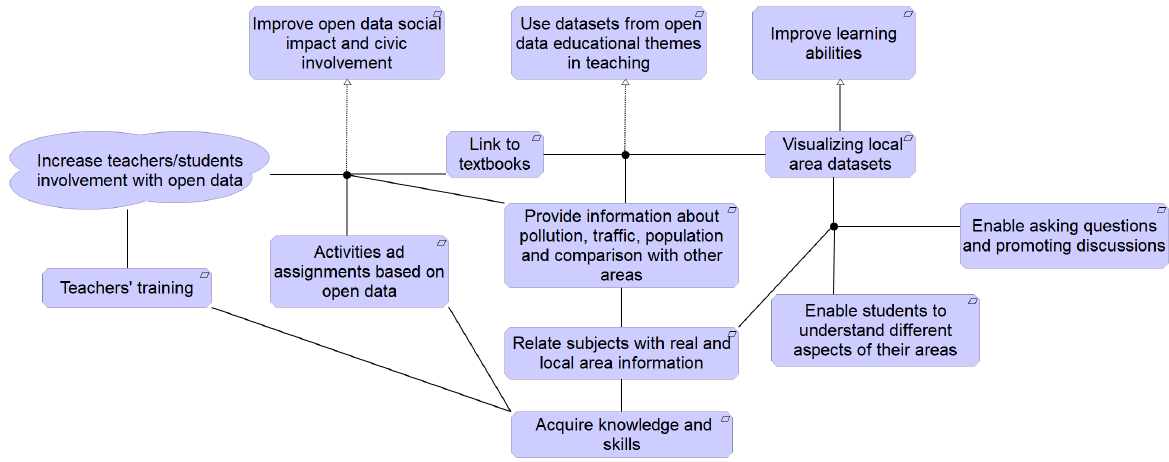
Figure 5. Motivational layer requirements